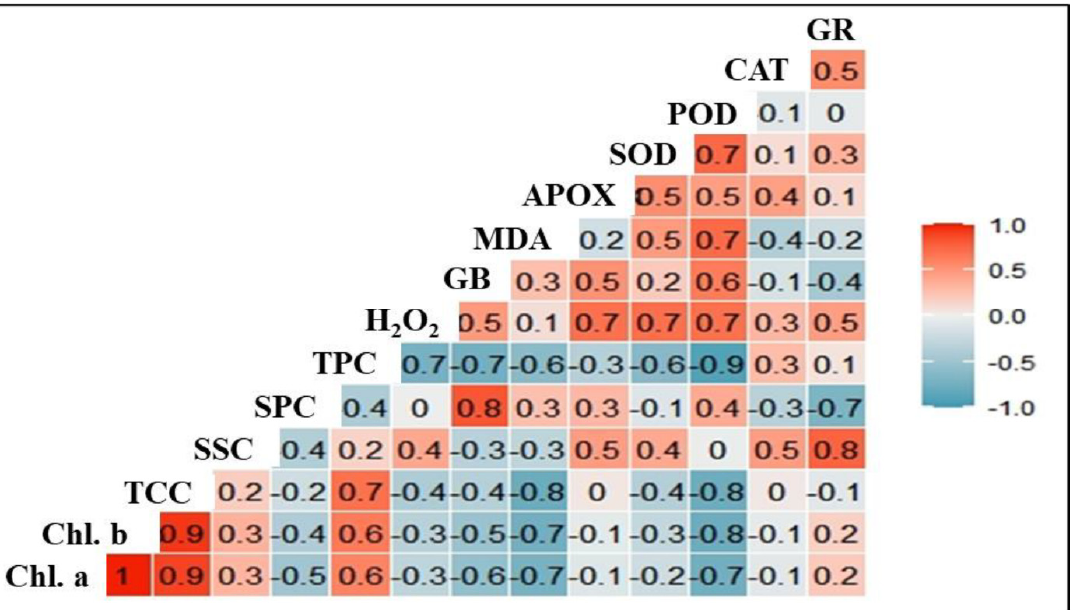
Figure 5. Correlation between various physio-biochemical activities of A. sativa under drought stress conditions.